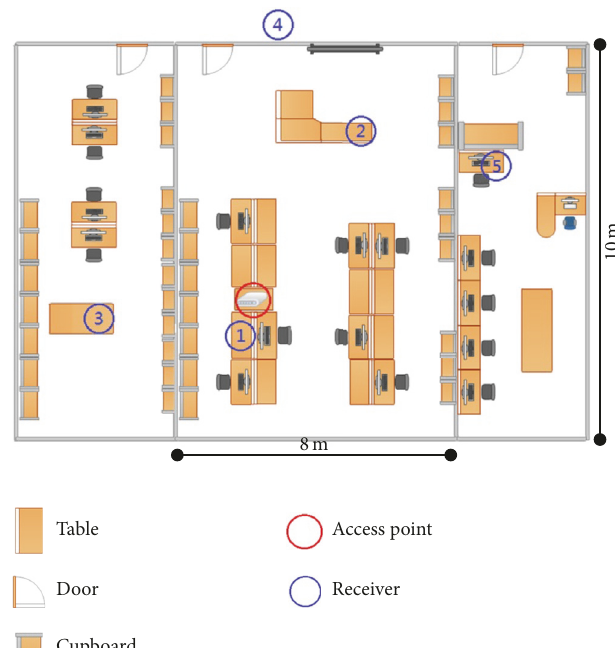
Figure 16: Experimental network scenario 4.